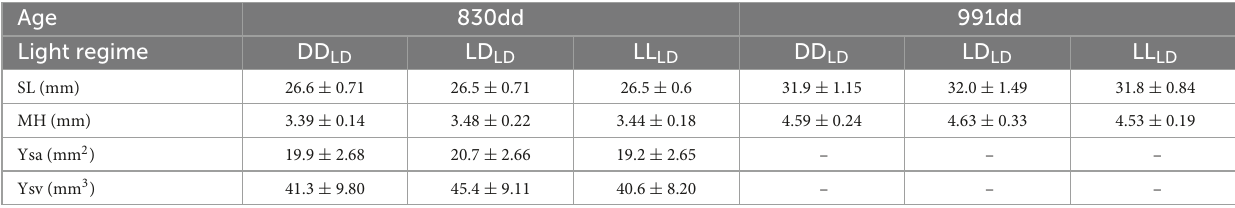
TABLE 1 Morphometric data for first feeding Atlantic salmon at 830- and 991-day degrees (dd) (1 and 3 weeks after offered feed for the first time). Age 830dd 991dd Light regime DD LD LD LD